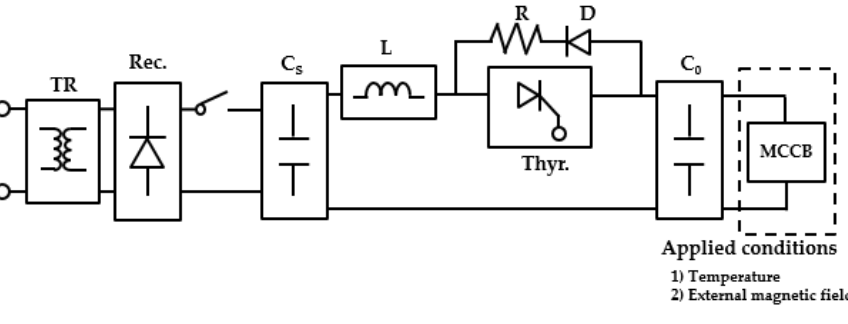
Figure 3. Experiment circuit.